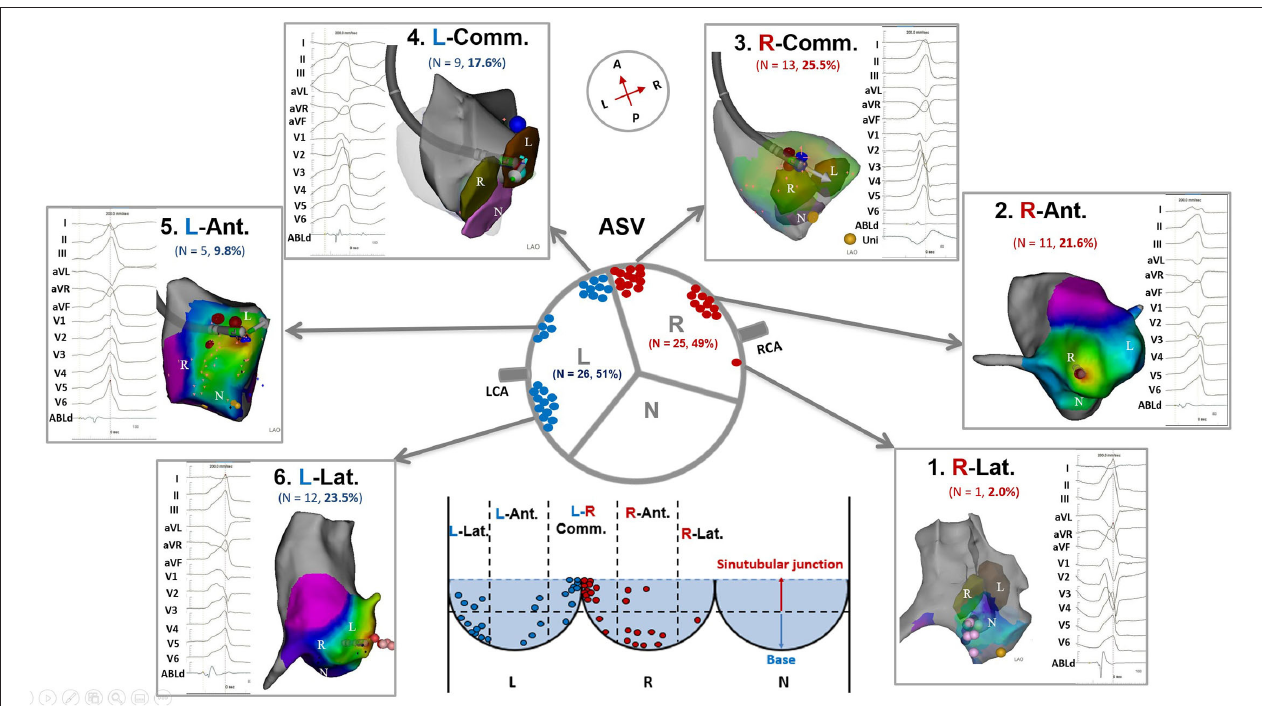
FIGURE 1 | Anatomic distributions of ventricular arrhythmias ablated in the ASVs. ASV, aortic sinus of Valsalva; N, non-coronary ASV; L, left ASV; R, right ASV; RCA, right coronary artery; LCA, left coronary artery; R-Lat., right-lateral ASV; R-Ant., right-anterior ASV; R-Comm., right side adjacent to the left-right commissure; L-Comm., left side adjacent to the left-right commissure; L-Ant., left-anterior ASV; L-Lat., left-lateral